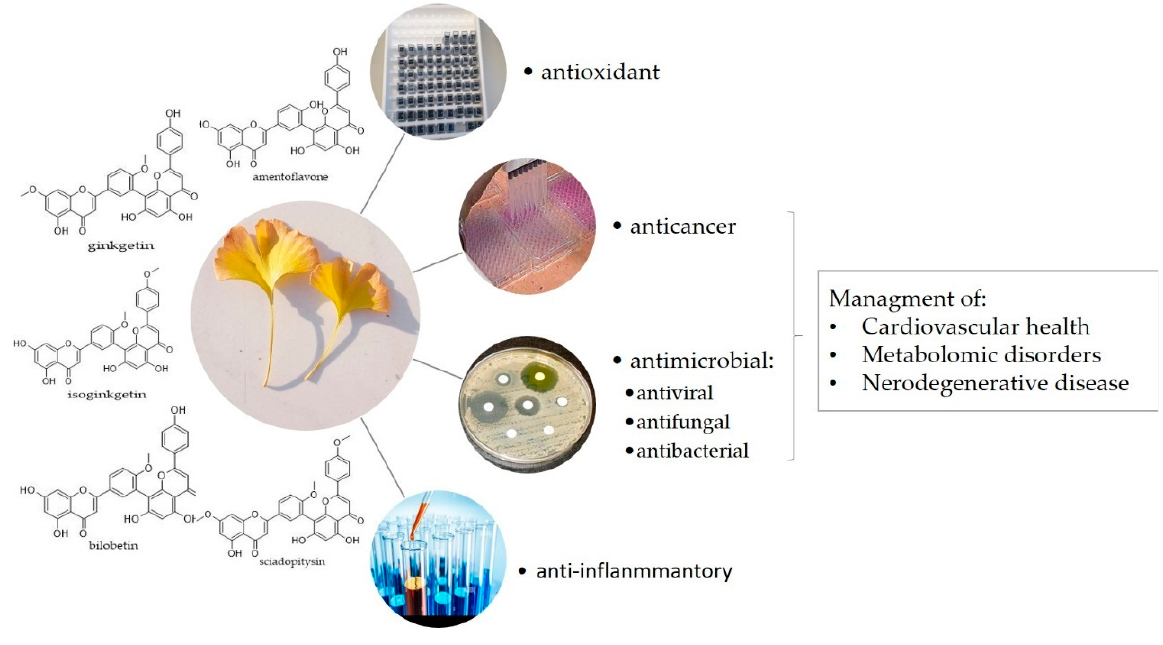
Figure 3. Bioactivity of G. biloba biflavonoids.